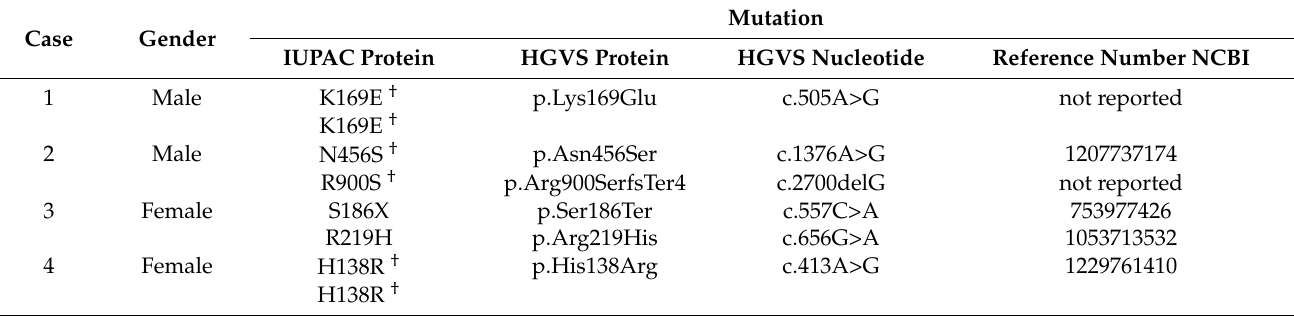
Table 3. Molecular analysis of patients with microvillus inclusion disease included in the present